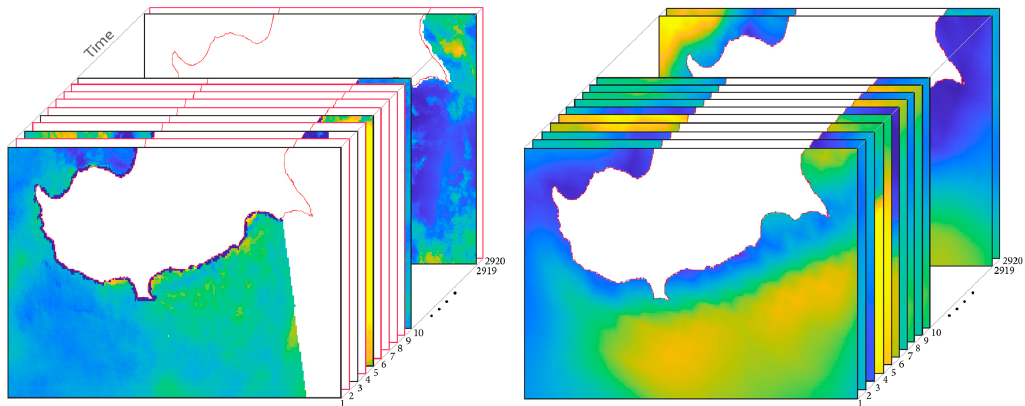
Figure 2. Sentinel-1 and UERRA image time series over the 2-year period of interest. Images with a red outline (left) represent Sentinel-1 gap datetimes.